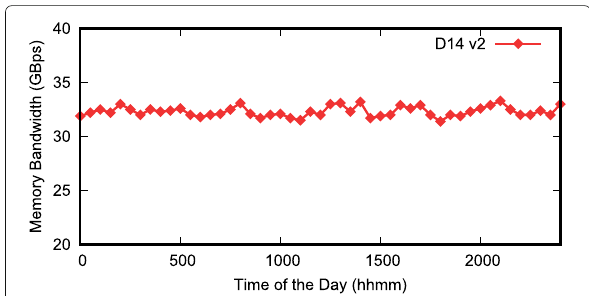
Fig. 4 Variation of memory bandwidth on an Azure D14 instance. The graph shows the variation in memory bandwidth on an idle Azure cloud instance during the course of a day. This depicts the general trend on public clouds and lays the foundation for the inference that a sudden steep decrease in bandwidth can be due to a side channel